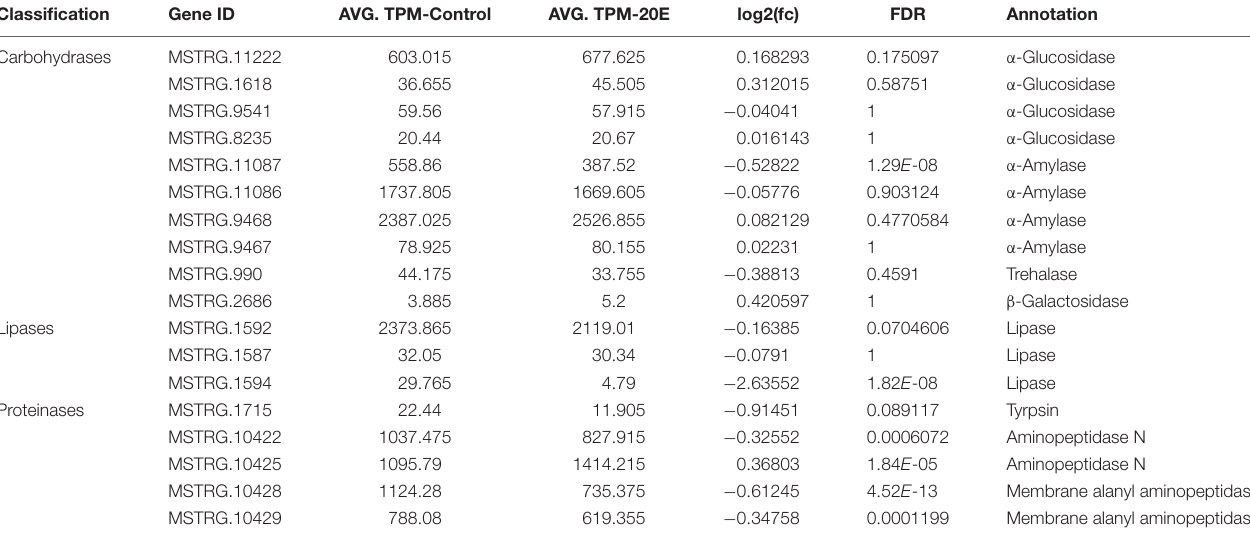
TABLE 1 | Identification and expression of genes encoding digestive